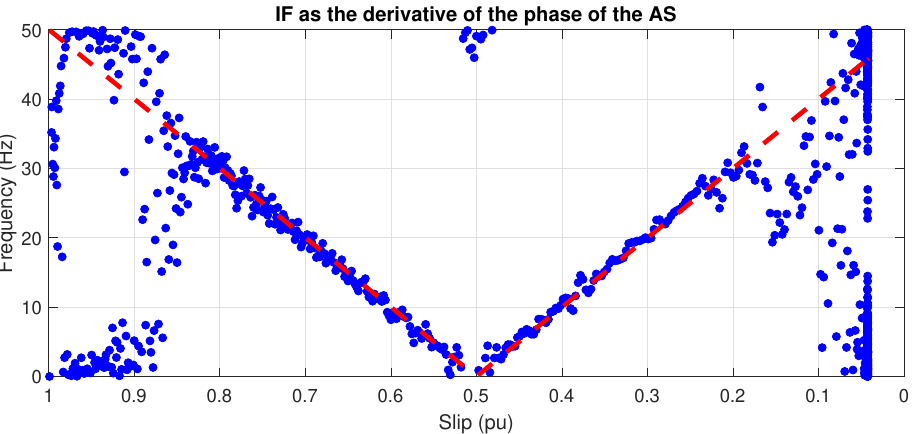
Figure 3. Instantaneous frequency of the LSHst versus slip, computed through the analytic signal. Dashed, red line: theoretical evolution of the fault harmonic. Blue dots: evolution of the LSHst of the simulated